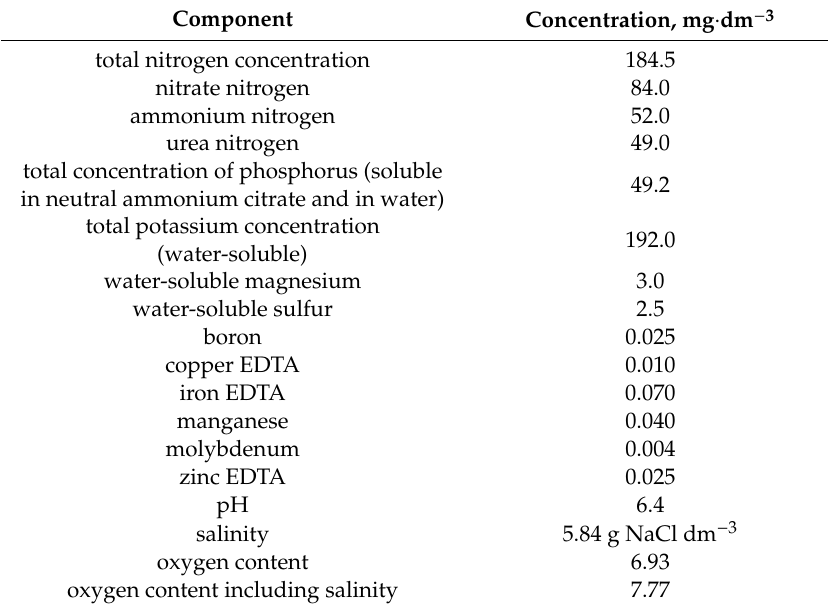
Table 1. Composition of culture